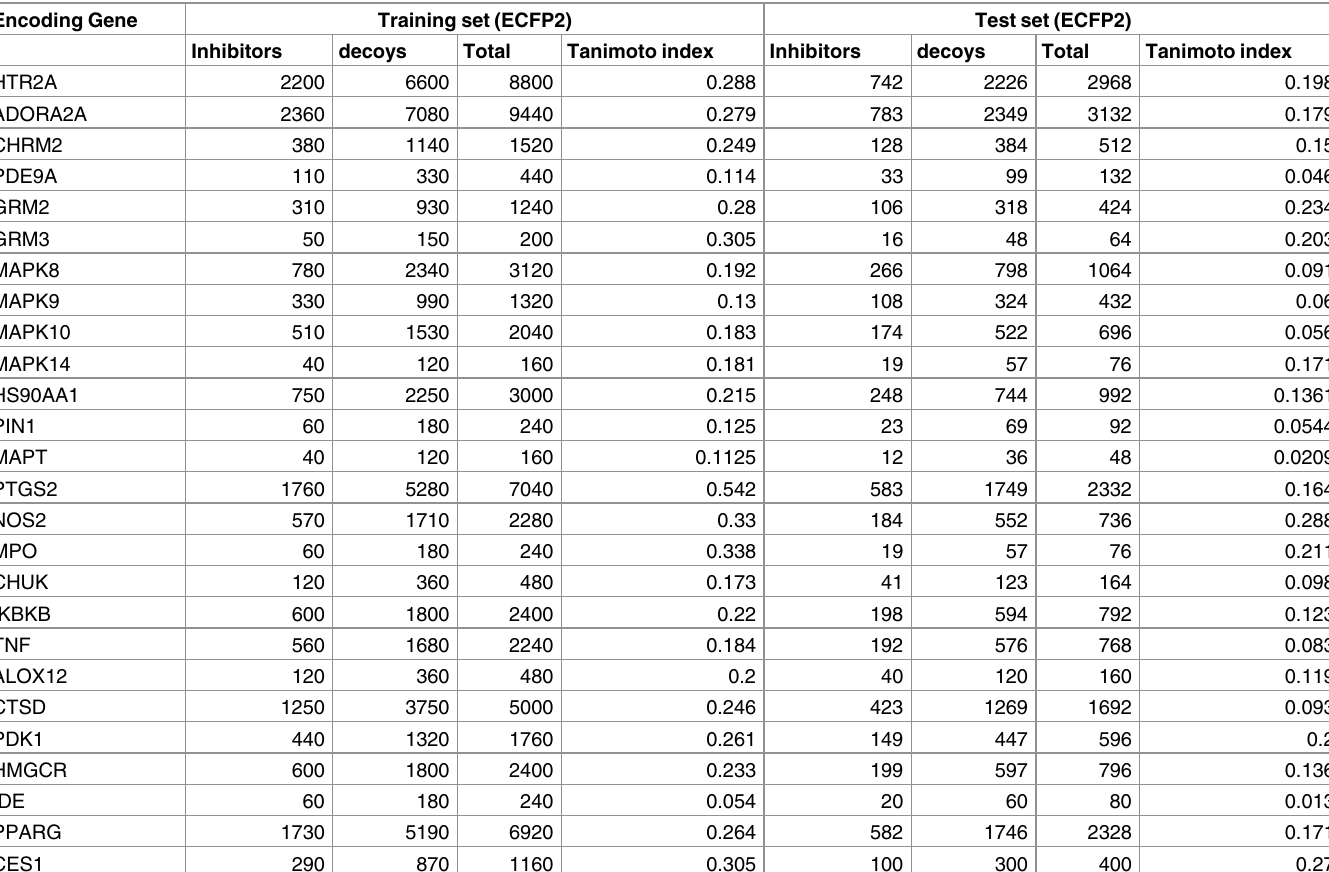
Table 1. Detailed statistical description of the entire data set based on the multi-label classification